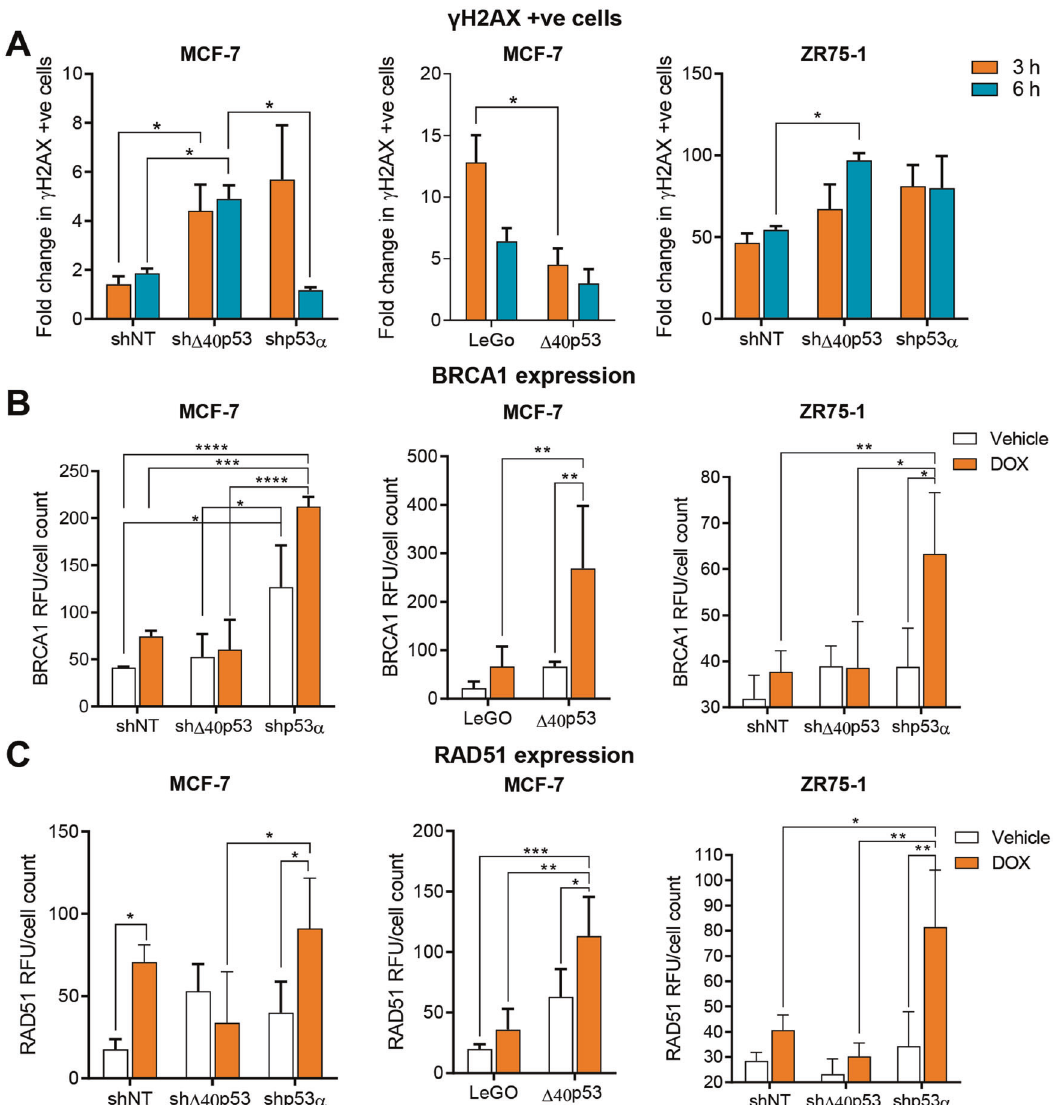
Fig. 6 Knockdown of Δ 40p53 increases DNA damage following DOX treatment at early time points. A γ H2AX + ve cells after treatment with DOX (3 and 6 h) and normalised by the 0 h in the MCF-7 (-shNT, -sh Δ 40p53, -shp53 α , LeGO and Δ 40p53) and ZR75-1 (-shNT, -sh Δ 40p53, -shp53 α ) sublines. γ H2AX (1:50) primary antibody was used. Data shown represent three independent experiments of three technical replicates. B BRCA1 and C RAD51 expression after treatment with vehicle (water) or DOX (3 h) in the MCF-7 (-shNT, -sh Δ 40p53, -shp53 α ,